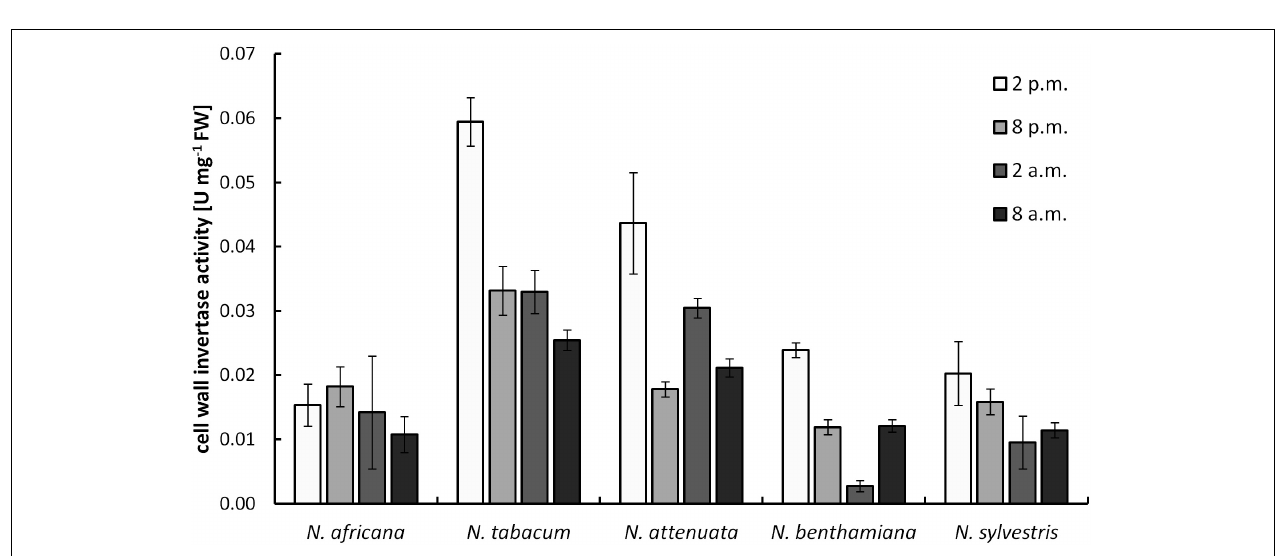
FIGURE 4 | Starch concentration in nectaries. Mean values from all measurements taken at one time point ( n = 3) and the respective SDs were plotted.